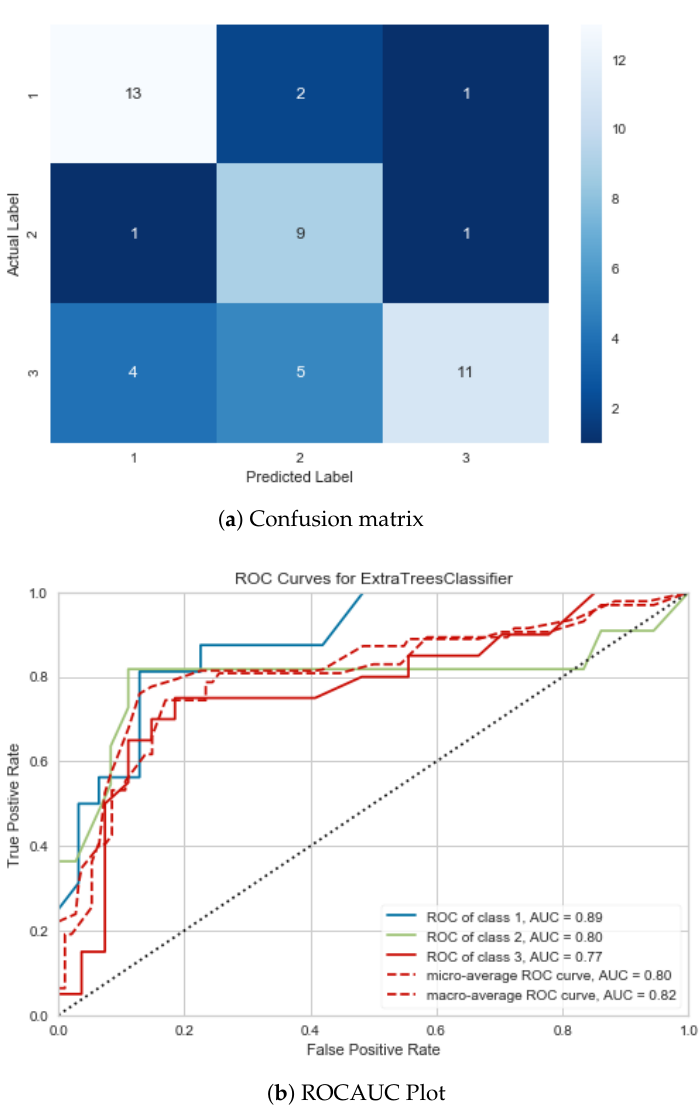
Figure 11. Performance of ET on Ecuador.